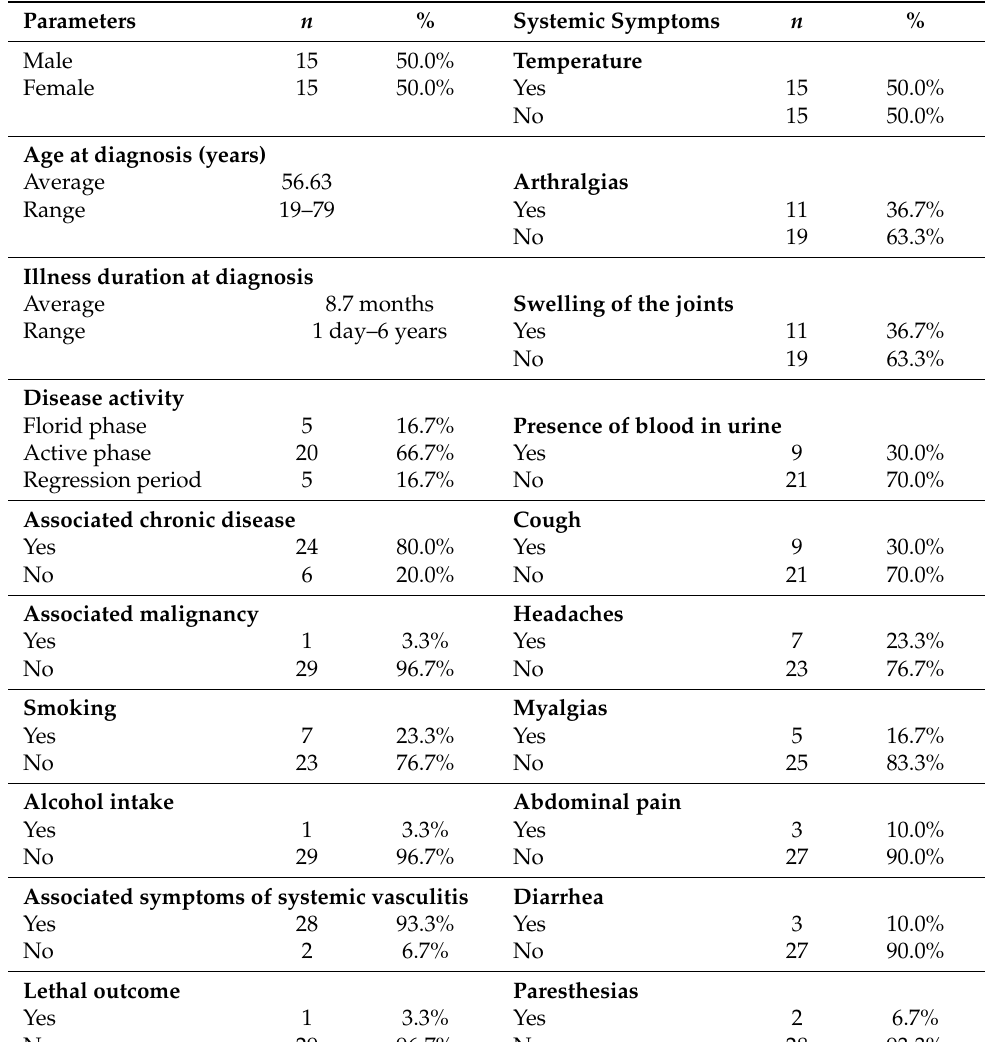
Table 2. Characteristics of the prospective patients with SVV ( n =